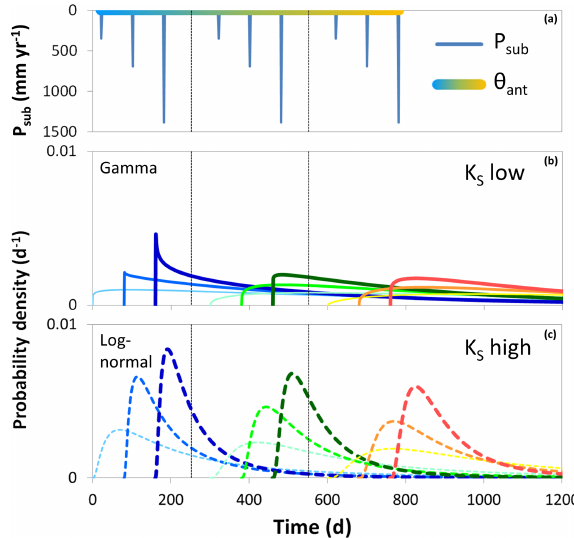
Figure 15. Predicted TTD shapes based on their relationship to the flow path number F , resulting from different antecedent moisture conditions θ ant (from blue – wet – on the left to yellow – dry – on the right) and subsequent precipitation amounts P sub . TTDs for low K S are gamma distributions (b) ; for high K S they are log-normal distributions (c) . Individual TTDs start with time shifts so that they do not overlap (individual start times correspond to the P sub mark- ers in a